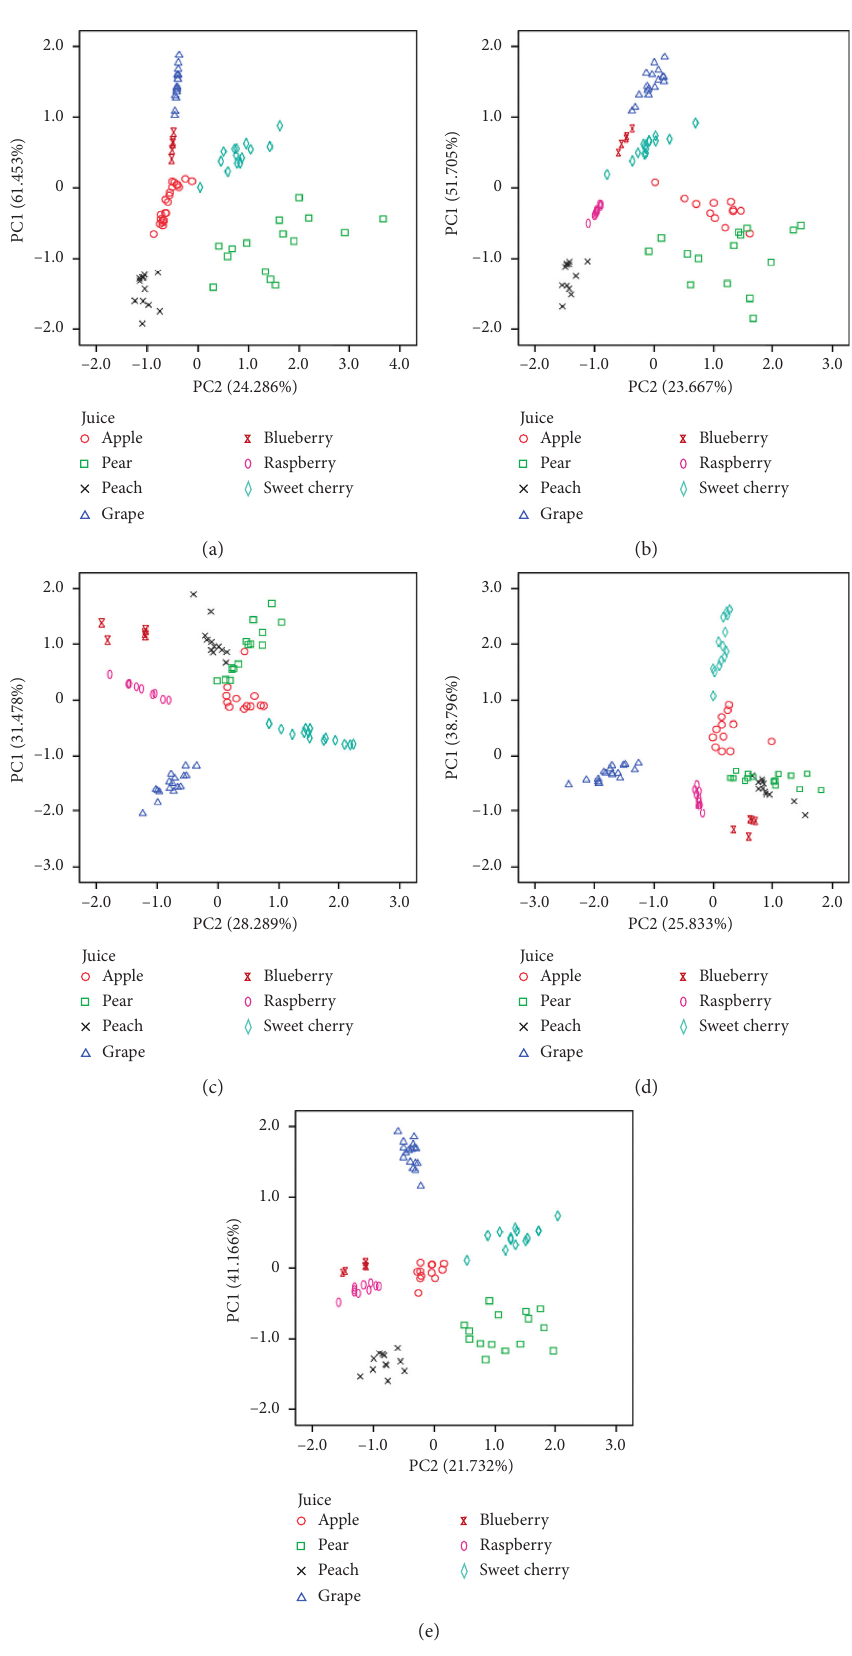
Figure 1: Score plots of PC1 vs. PC2 obtained with all analyzed samples used as analytical data for PCA: (a) sugar content; (b) sugar content combined with Fru/Glu; (c) organic acid content; (d) organic acid content combined with malic/citric; (e) sugar content combined with organic acid